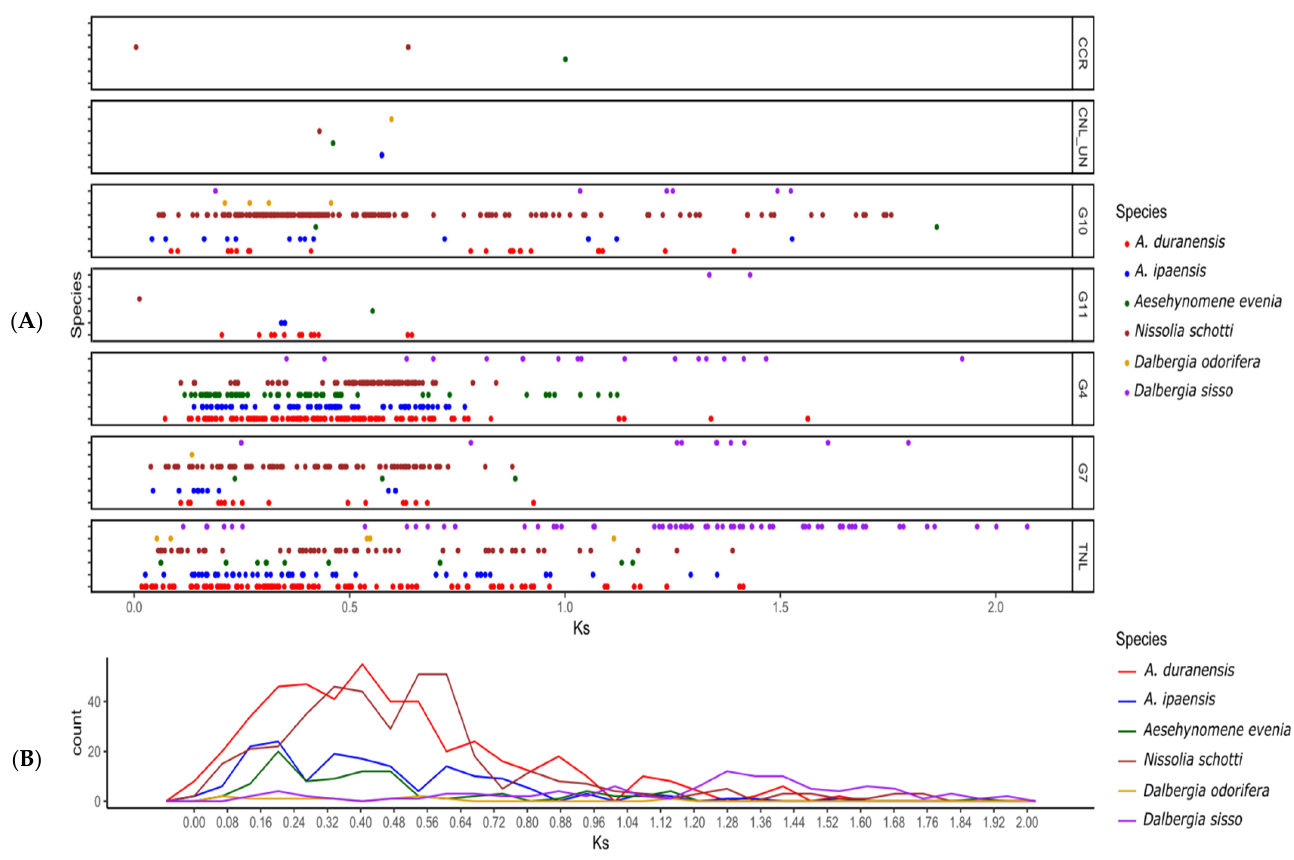
Figure 5. Evaluation of historical NLR gene duplication in the genus of Dalbergia . All six species belonging to Dalbergioids with Ks values of their paralogs are represented. ( A ) X and Y axis indicating the Ks values and their frequencies. ( B ) Generalized Dalbergioids duplication pattern. ( B ) These boxplots show the Ks values between Dalbergia and Arachis species. A middle line represents the median of Ks.